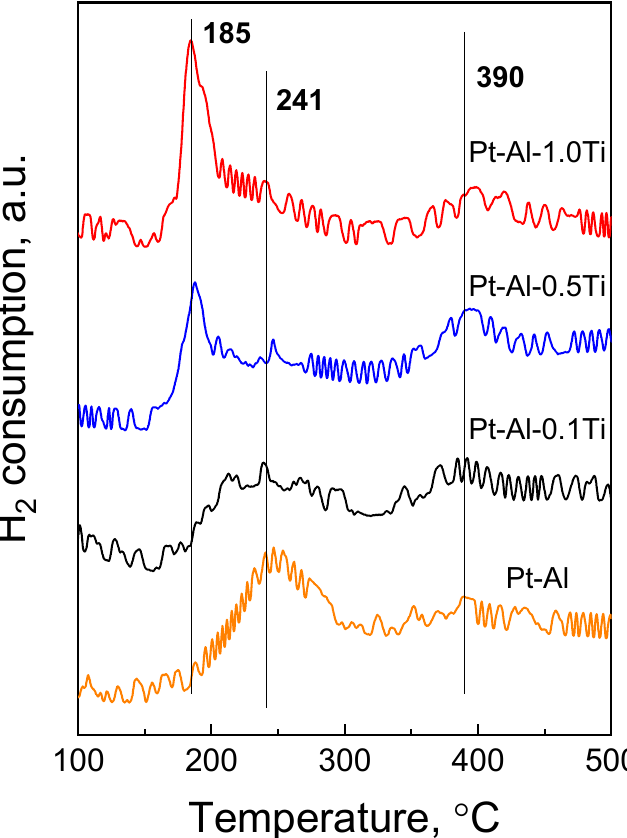
Figure 7. Temperature-programmed reduction (TPR-H 2 ) profiles of Pt catalysts.